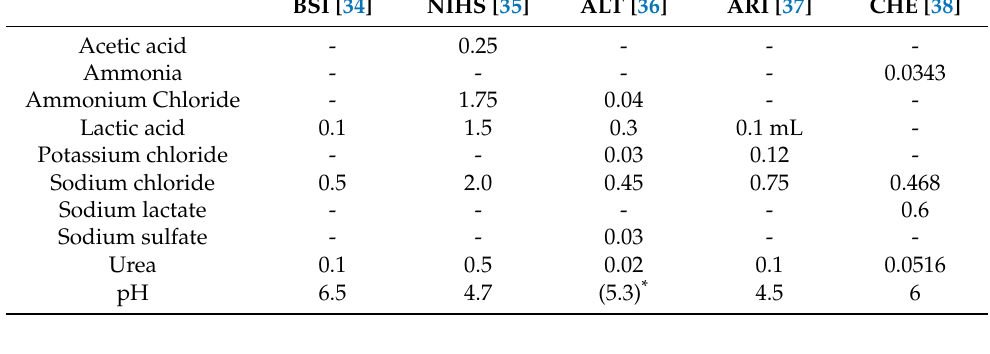
Table 1. Composition of the artificial sweat solutions (grams of reagent used to prepare 100 mL of solution unless otherwise stated).